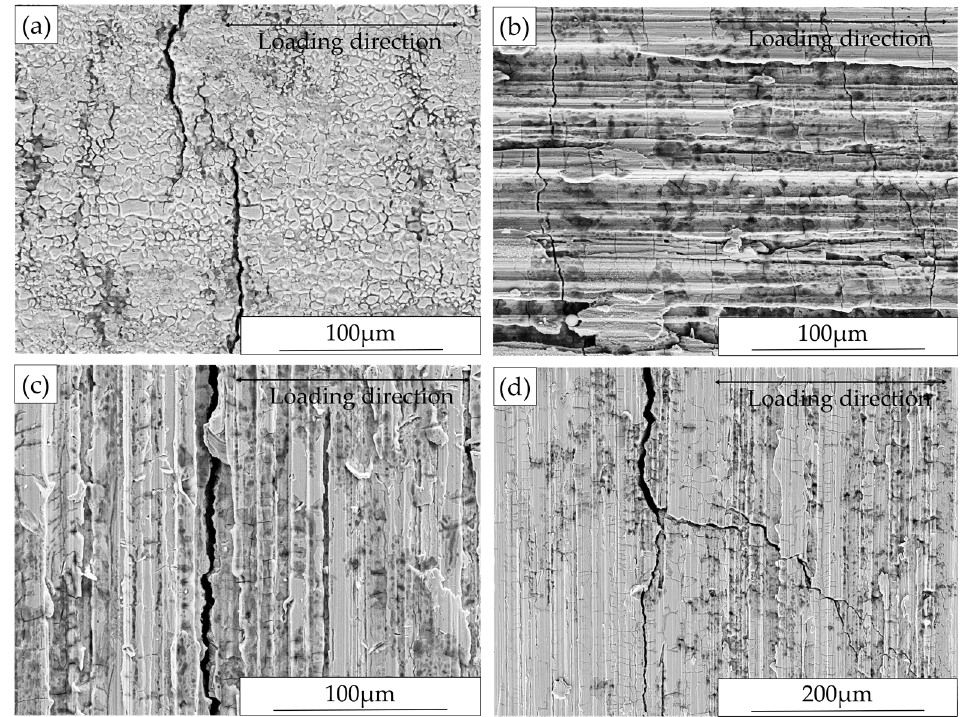
Figure 9. Surface morphology after exposure under four-point bend loading: ( a ) AD-RD specimen at 900 MPa; ( b ) Ground-RD-RD specimen at 700 MPa; ( c ) Ground-RD-TD at 700 MPa; and ( d ) Ground-TD-RD specimen at 700 MPa.